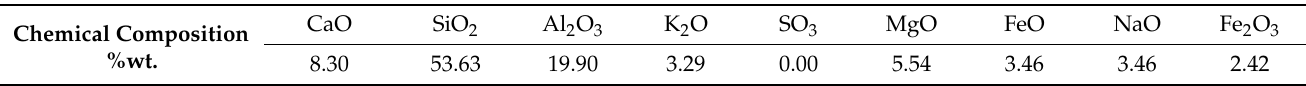
Table 1. Chemical composition of fine granite fraction. Chemical Composition